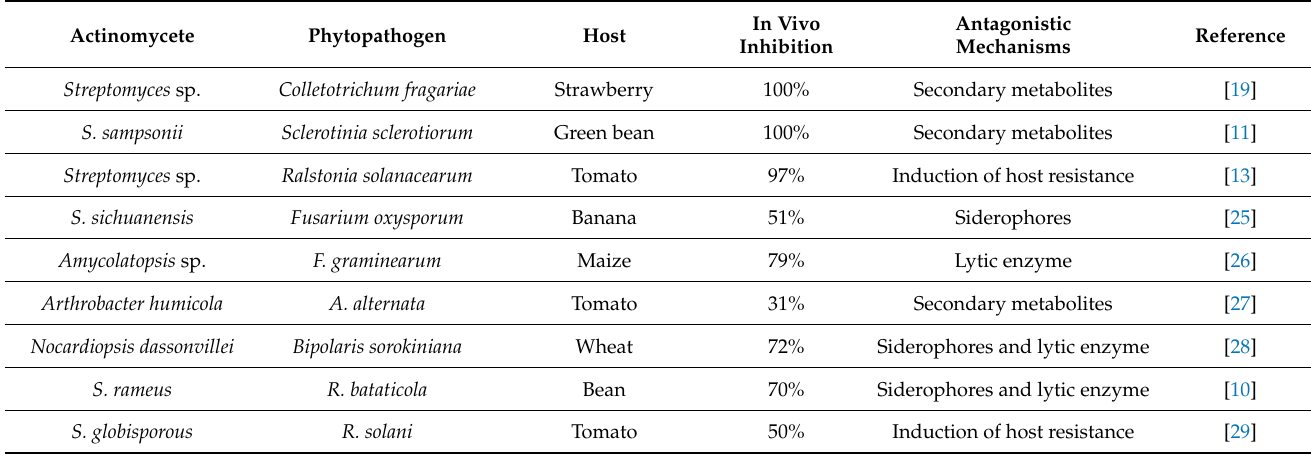
Table 1. Antagonistic mechanisms of actinomycetes for the control of phytopathogenic